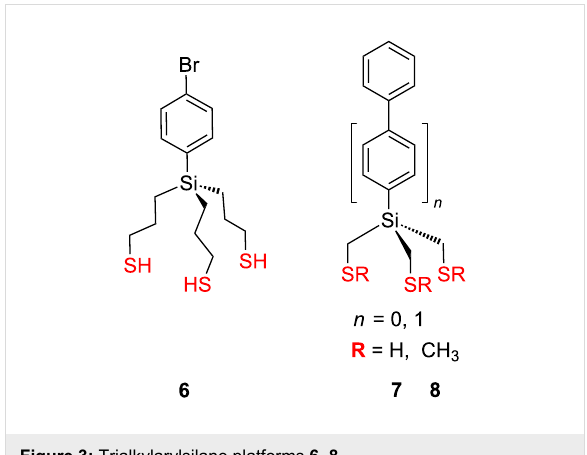
Figure 3: Trialkylarylsilane platforms 6–8